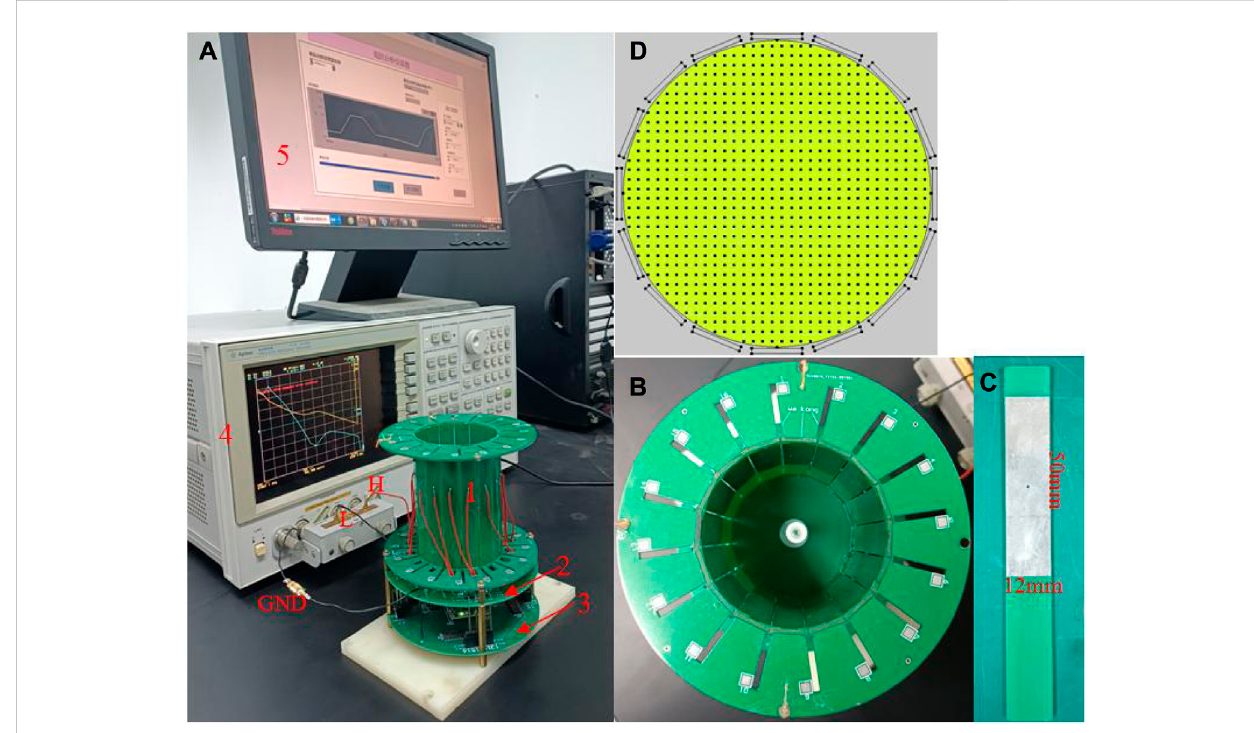
FIGURE 1 PhotographsoftheECTmeasurementsystemandsensor. (A) Measurementsystem, (B) ECTsensor, (C) electrode,and (D) pixelpointsoftheimaging area.